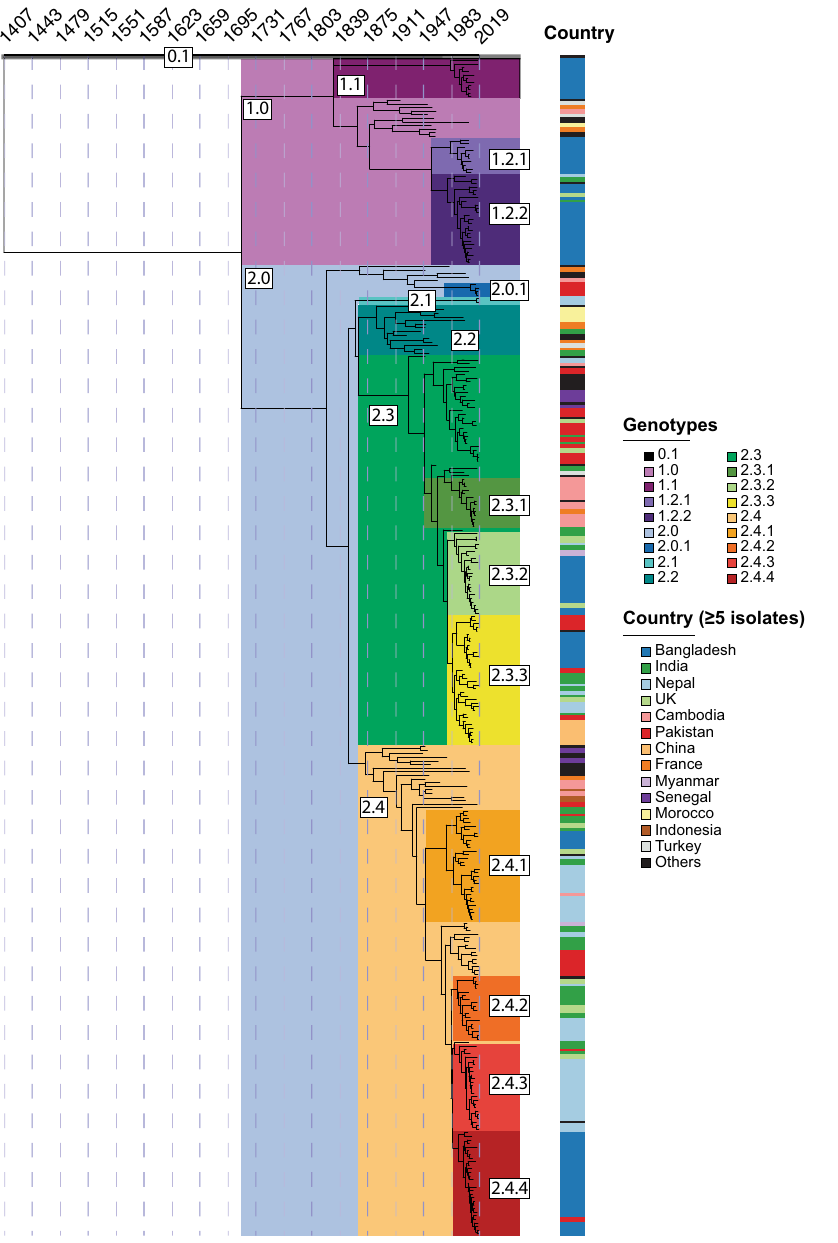
genotypes are temporally resolved. Countries with greater than or equal to 5 iso- lates are also